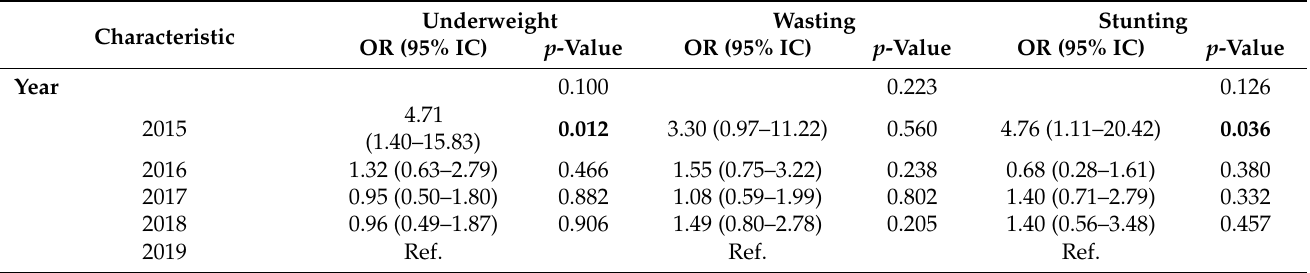
Table 3. Adjusted odds ratio and corresponding confidence interval obtained through multiple logistic regression models for each undernutrition status of